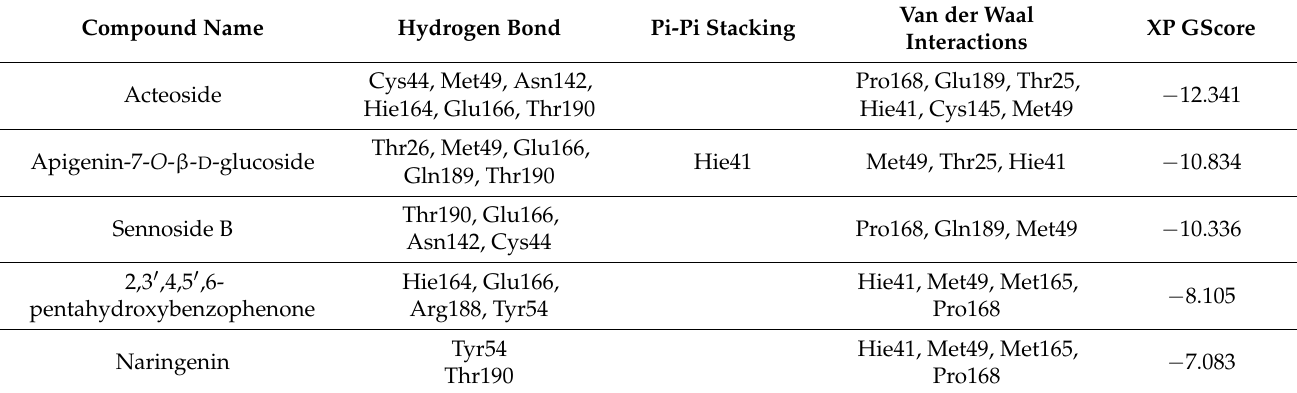
Figure 2. Inhibition of 3CL Protease enzyme activity by compounds; 2,3 (cid:48) ,4,5 (cid:48) ,6-Pentahydroxybenzophenone, sennoside B, narigenin, apigenin-7-O- β - D -glucoside, and acteoside. Table 3. Interaction of natural compound inhibitors with active site residues of SARS-CoV-2 M PRO